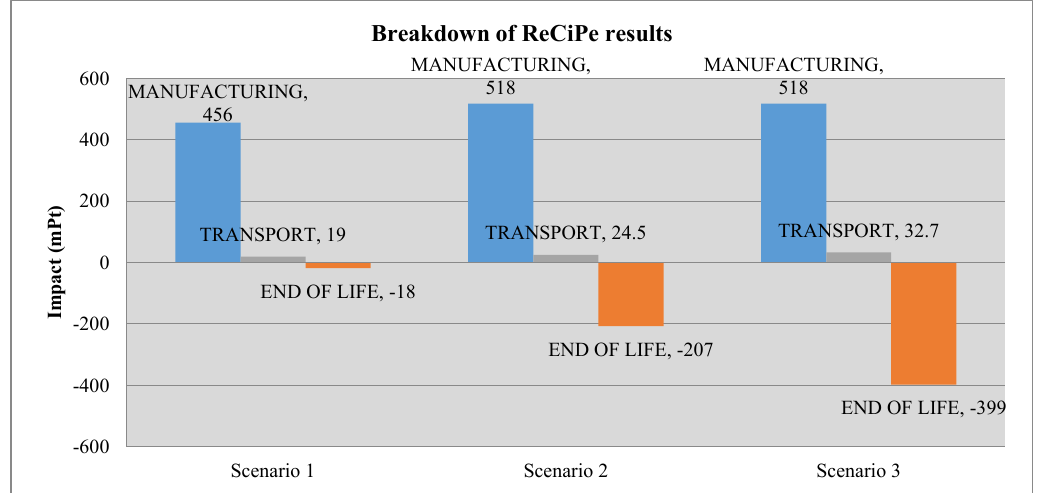
Figure 8. Breakdown of the ReCiPe